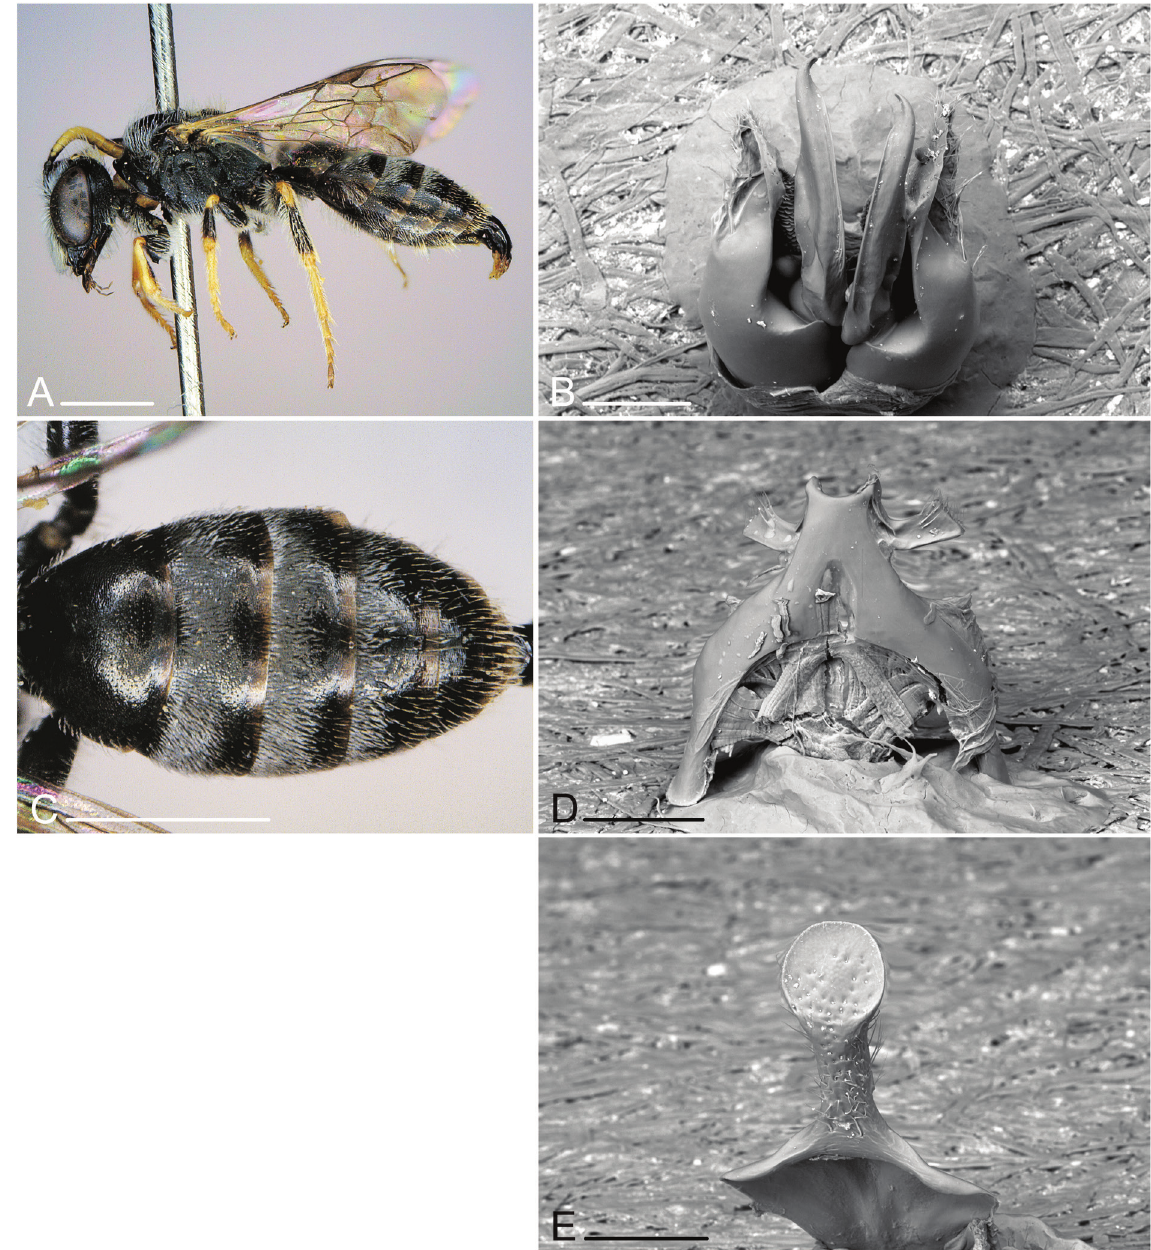
Fig. 7. Scrapter exiguus sp. nov., ♂. A . Lateral view. B . Genitalia (dorsal view, SEM). C . Metasoma (dorsal view). D . S7 (dorsal view, SEM). E . S8, apical end (SEM). Scale bars: photos: 1 mm, SEM: 0.1